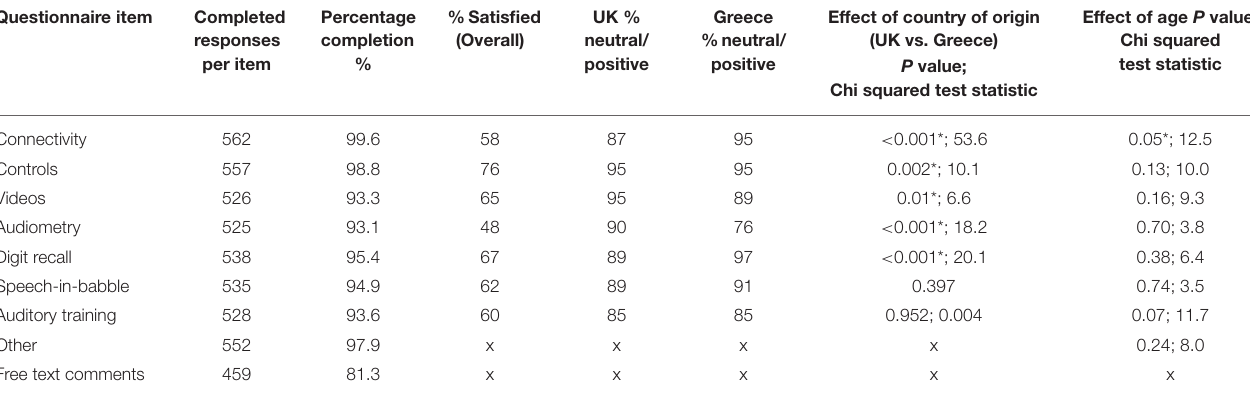
TABLE 2 | Response completion and satisfaction by feedback questionnaire item, according to country of origin and age ( n = 564 returned questionnaires). Questionnaire